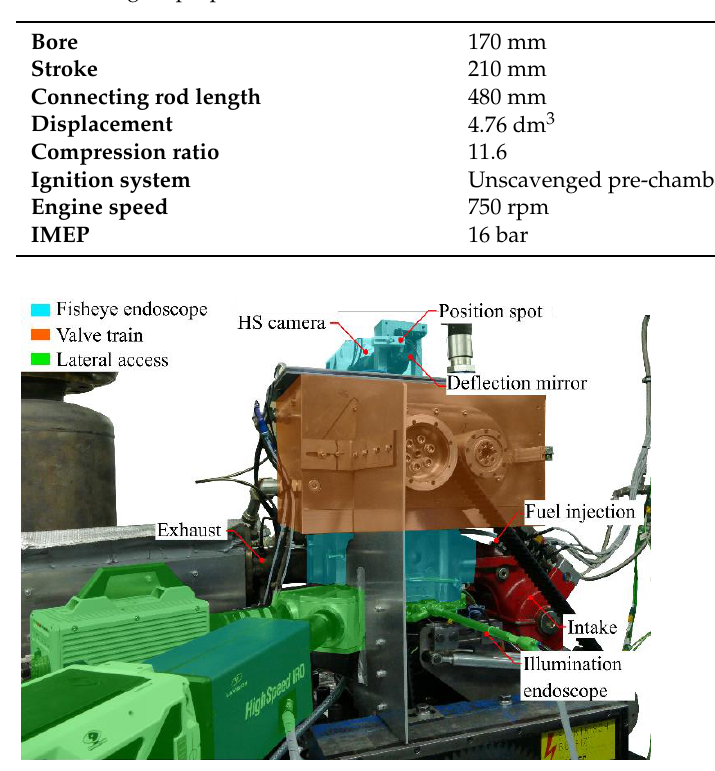
Figure 2. View of the engine setup at the test rig .